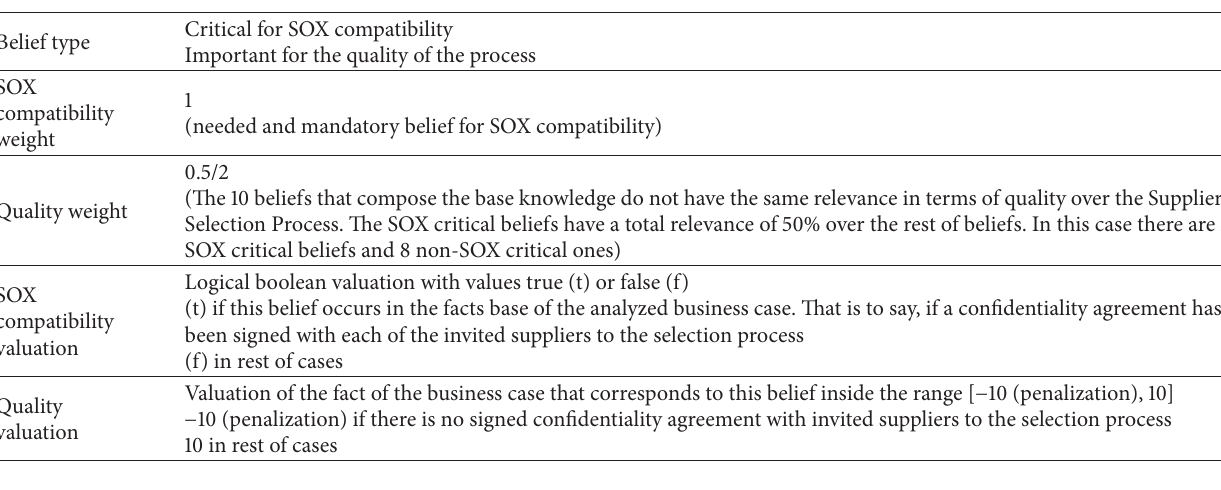
Table 3: Agreement of Confidentiality Scoring Protocol.